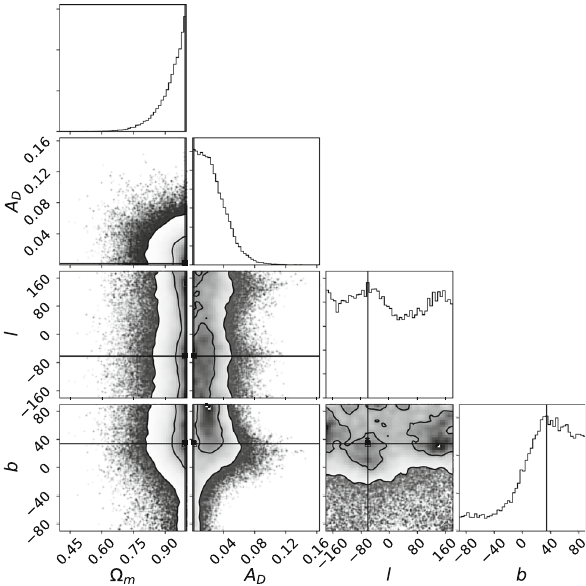
the two dipole directions is 29 . 5 ◦ . The results of parameters β , γ , and δ are summarized in Table